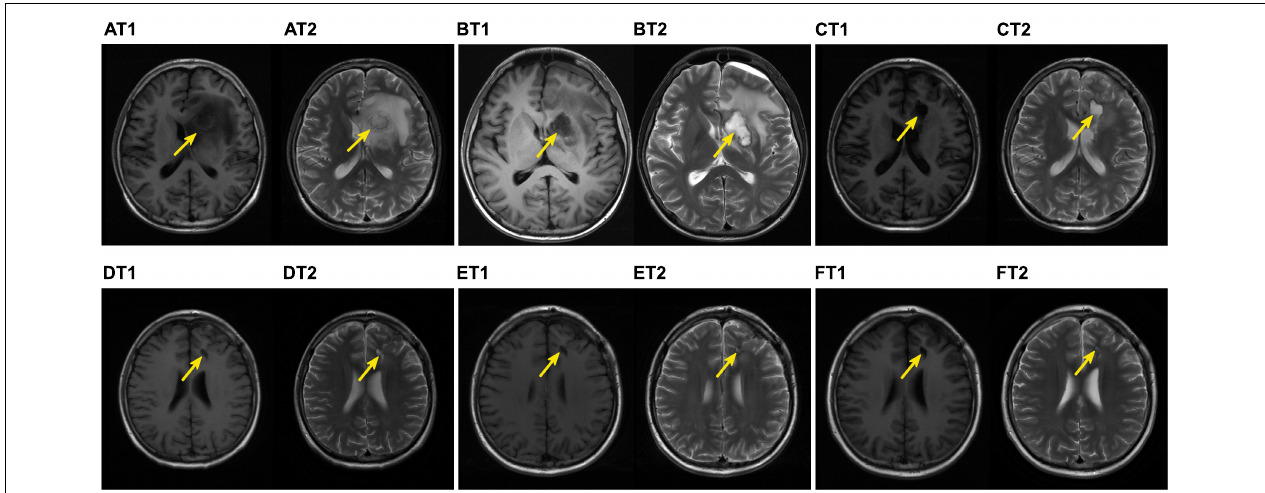
FIGURE 2 | Brain magnetic resonance imaging (MRI) findings. T1, magnetic resonance T1-weighted imaging. T2, magnetic resonance T2-weighted imaging. On day + 138 after haematopoietic stem cell transplantation (HSCT), the patient experienced persistent headache and violent mood swings. The follow-up MRI-T1 (A T 1 ) and MRI-T2 (A T 2 ) identified signal abnormalities (see yellow arrows) suggestive of left-side basal ganglia abscesses (28 × 18 mm) and signs of perifocal oedema (pre-operation). On day + 141 after HSCT, intracranial debridement was performed on the child. On day + 164 after HSCT, MRI-T1 (B T 1 ) and MRI-T2 (B T 2 ) showed that the basal ganglia mucormycosis was completely removed post-operation. On day + 183 after HSCT, MRI-T1 (C T 1 ) and MRI-T2 (C T 2 ) were performed post-operation. On day + 216 after HSCT, MRI-T1 (D T 1 ) and MRI-T2 (D T 2 ) were performed post-operation. On day + 251 after HSCT, MRI-T1 (E T 1 ) and MRI-T2 (E T 2 ) were performed post-operation. On day + 339 after HSCT, MRI-T1 (F T 1 ) and MRI-T2 (F T 2 ) revealed that the surgical site appeared to be healing well with a gradual reduction in